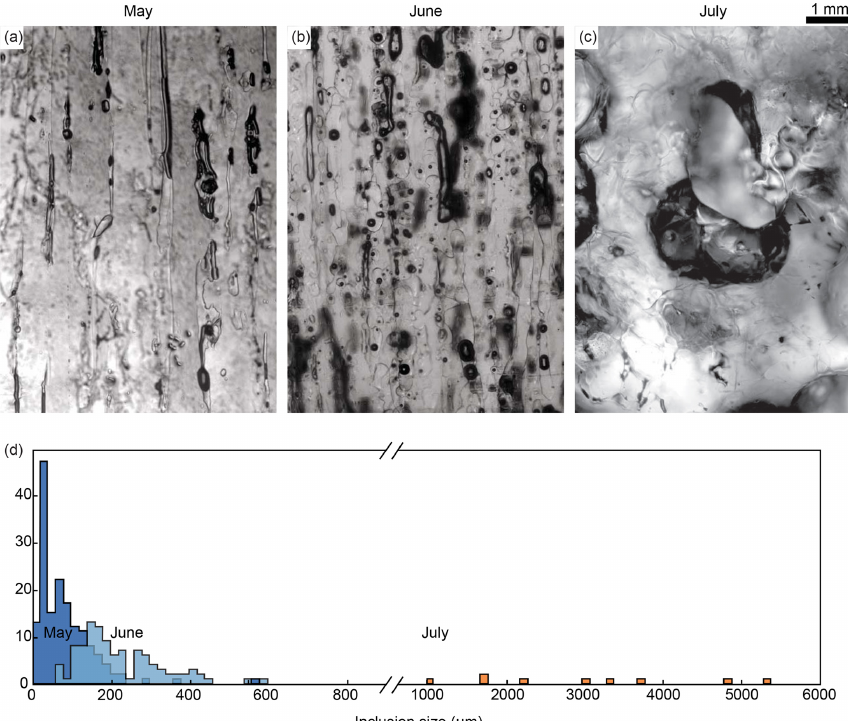
Figure 8. Ice sample vertical thin section transmitted light photomicrograph mosaics (a–c) and histogram of measured pore sizes (d) from May, June, and July ice samples, shown at the same scale. (a) Vertical thin section from the middle horizon of the M-CS-8 core (depth = 32– 52cm) showing vertical brine channels. (b) Vertical thin section from the middle horizon of the JN-CS-22 core (depth = 45–65cm) showing enlarged brine channels. (c) Vertical thin section from the middle horizon of JY10-CS-11 (depth = 32–42cm) showing pore space. (d) Pore size histogram indicating the maximum dimension of pores measured from thin sections collected in May (dark blue), June (light blue), and July